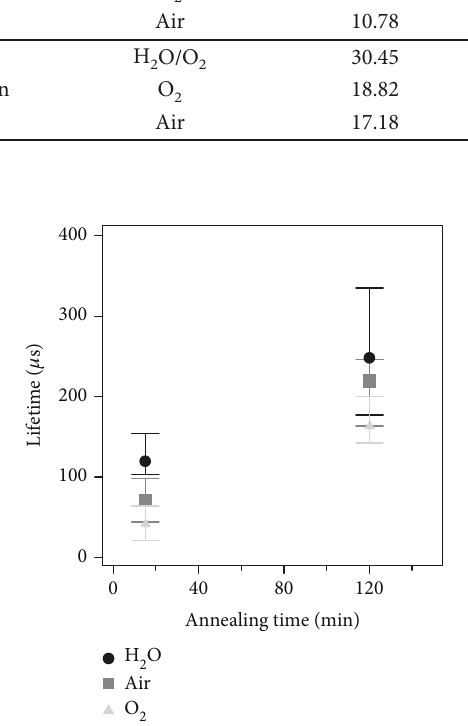
Figure 4: E ff ective carrier lifetime comparison of Al-acac-coated silicon wafers after annealing in di ff erent ambients (H and air) for 15 or 120min at 450 ° C.